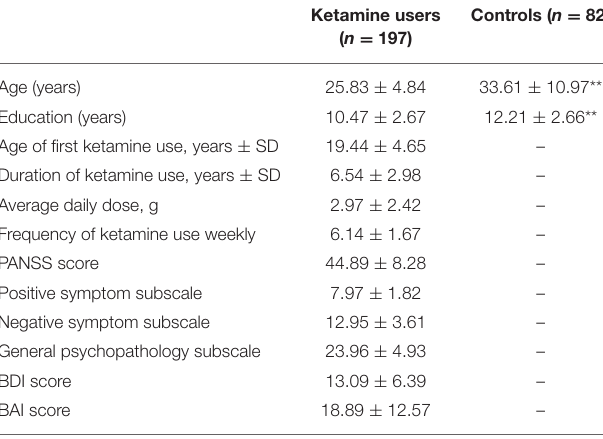
TABLE 1 | Demographics and clinical data of ketamine users and